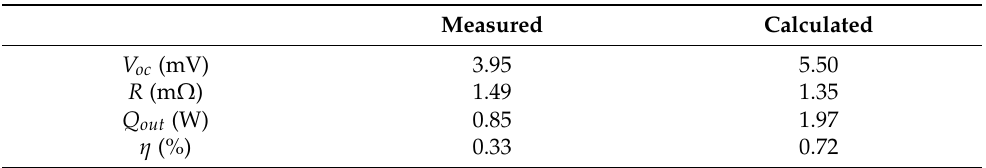
Table 2. Experimentally measured using MiniPEM and predicted V oc , R , and Q out at T avg = 298